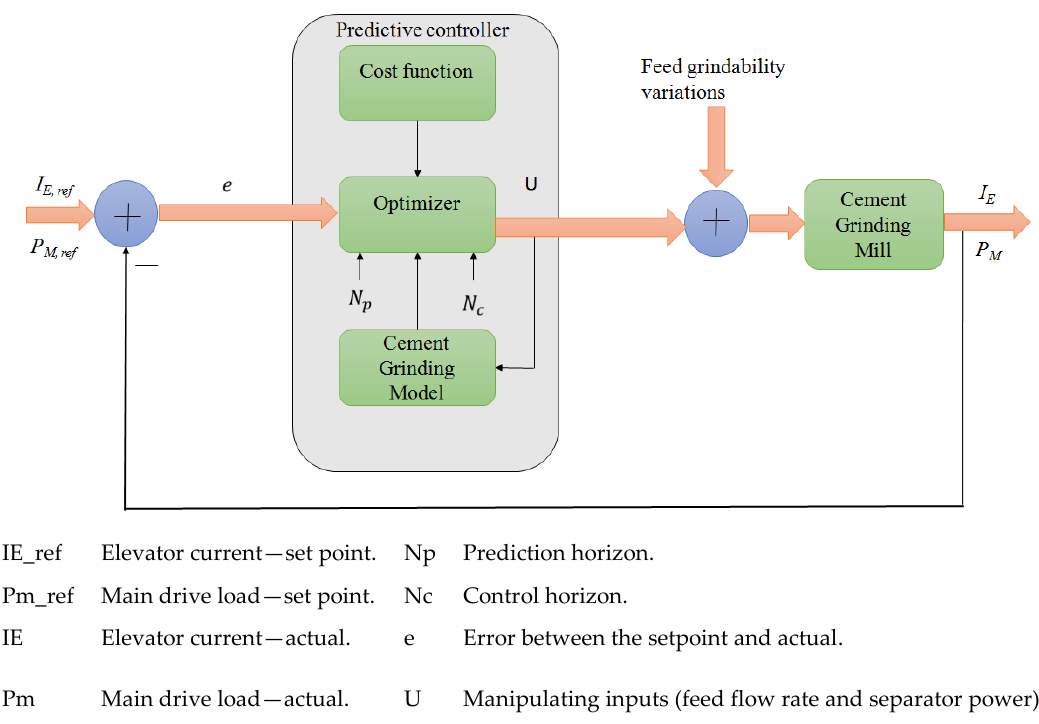
Figure 3. Schematic diagram of the predictive controller implemented for the cement grinding process.